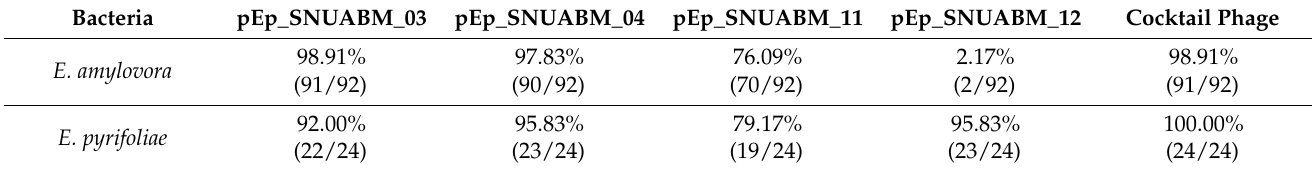
Table 3. Host range analysis of individual and combined Erwinia phages, alone and as and the combined cocktail.